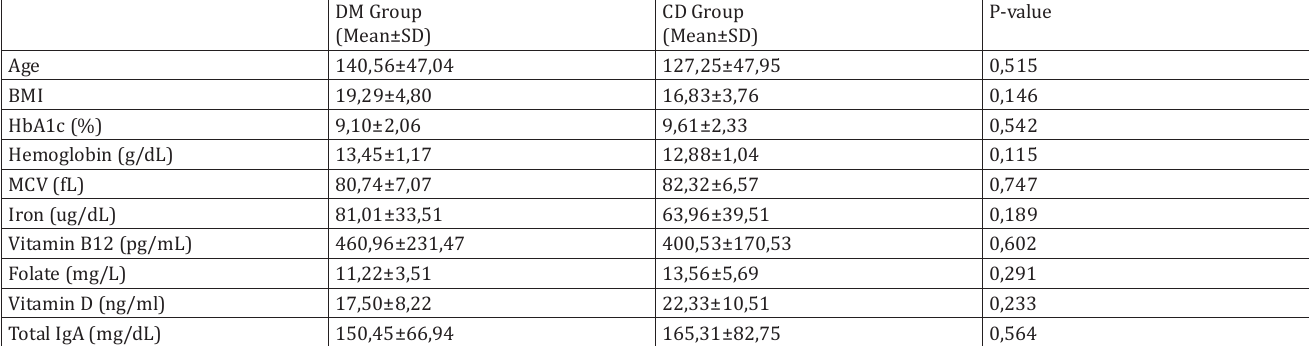
Comparison of clinical features and laboratory outcomes between CD and DM patients.